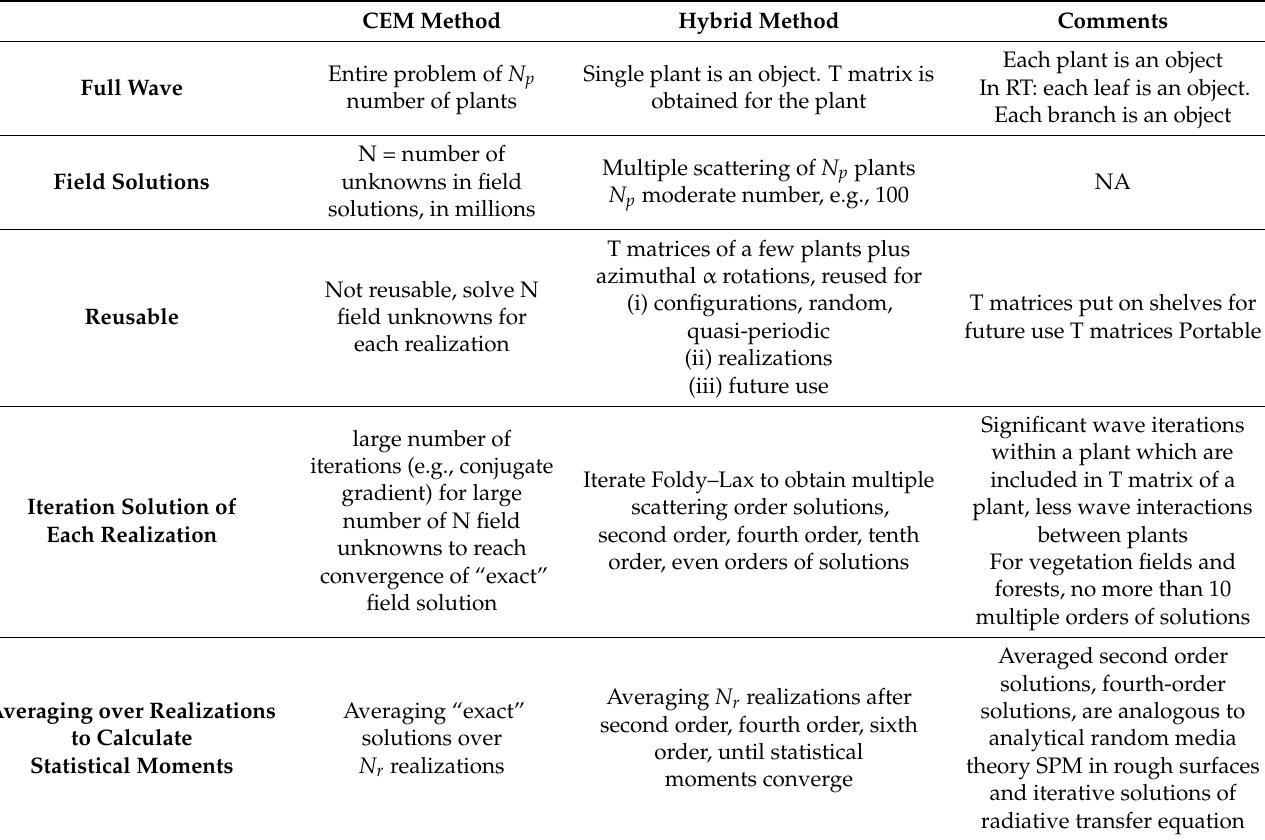
Table 1. Comparison between CEM method and hybrid